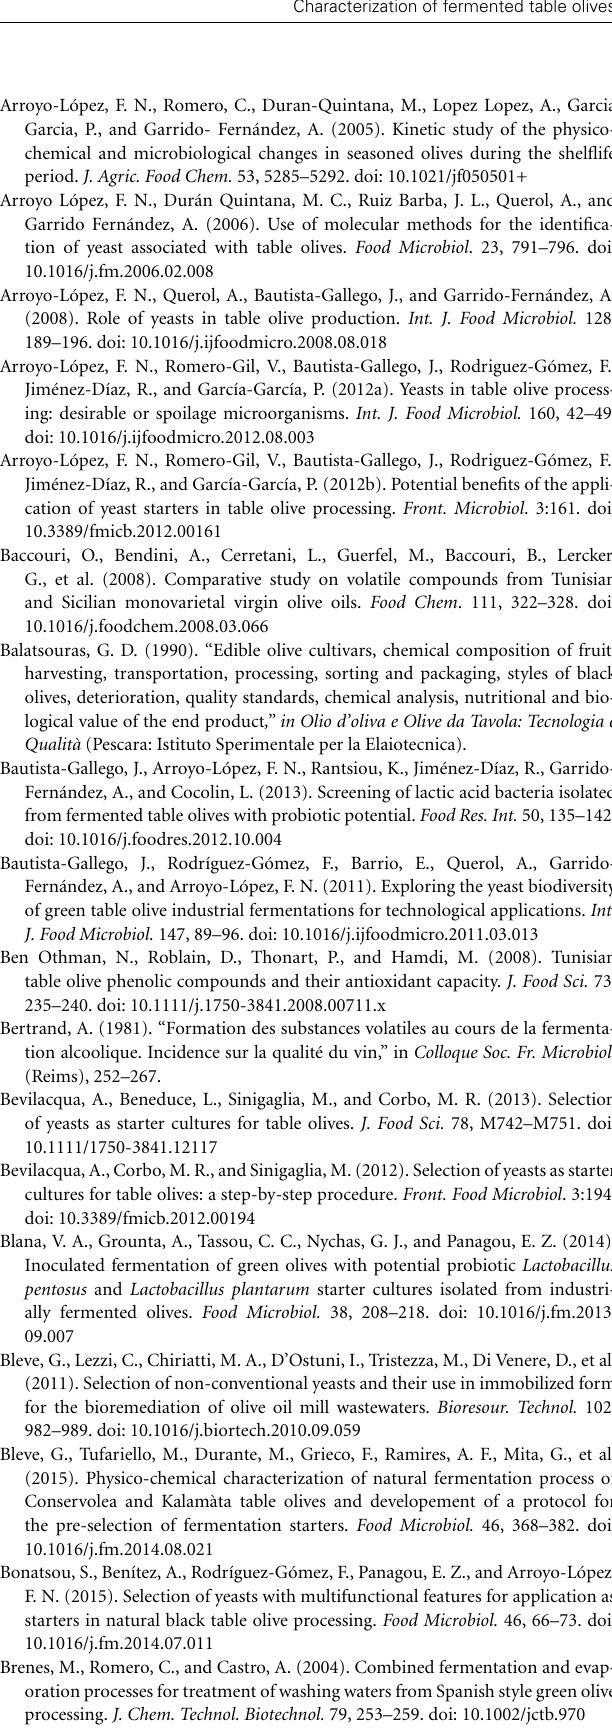
table olive fermentation. Food Microbiol . 30, 8–16. doi: 10.1016/j.fm.2011. 10.005